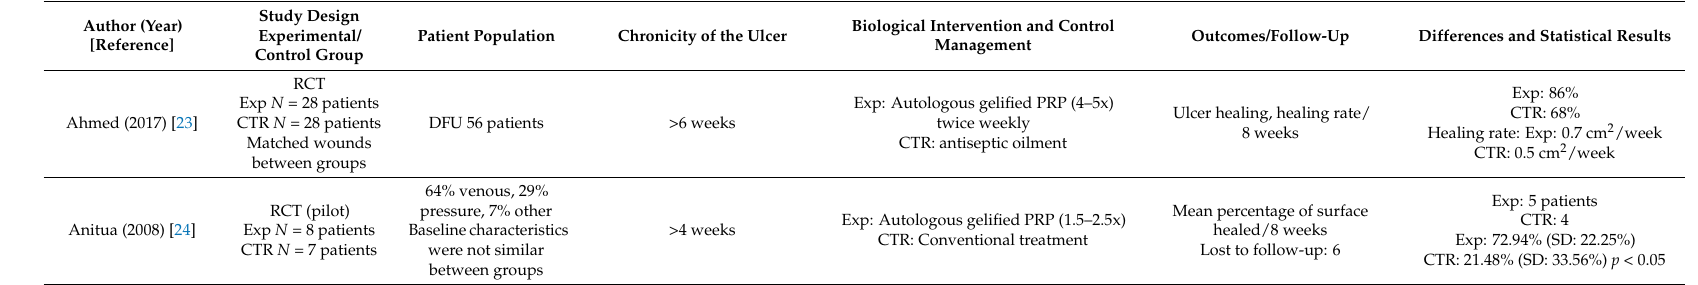
Table 2. Summary of platelet therapy